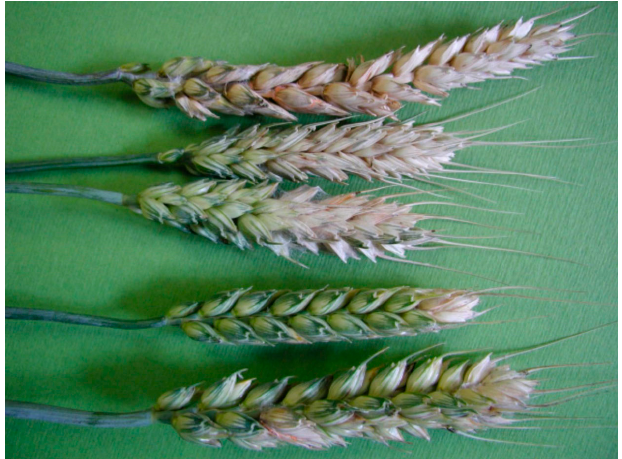
Figure 2. Example of FHB on wheat.